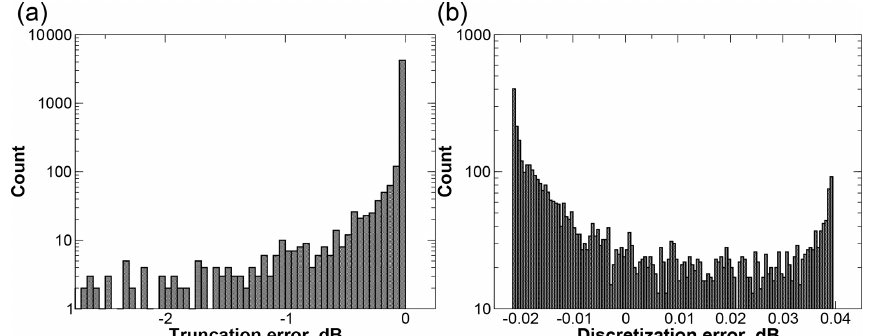
Figure 6. Histograms of errors for truncation and discretization.